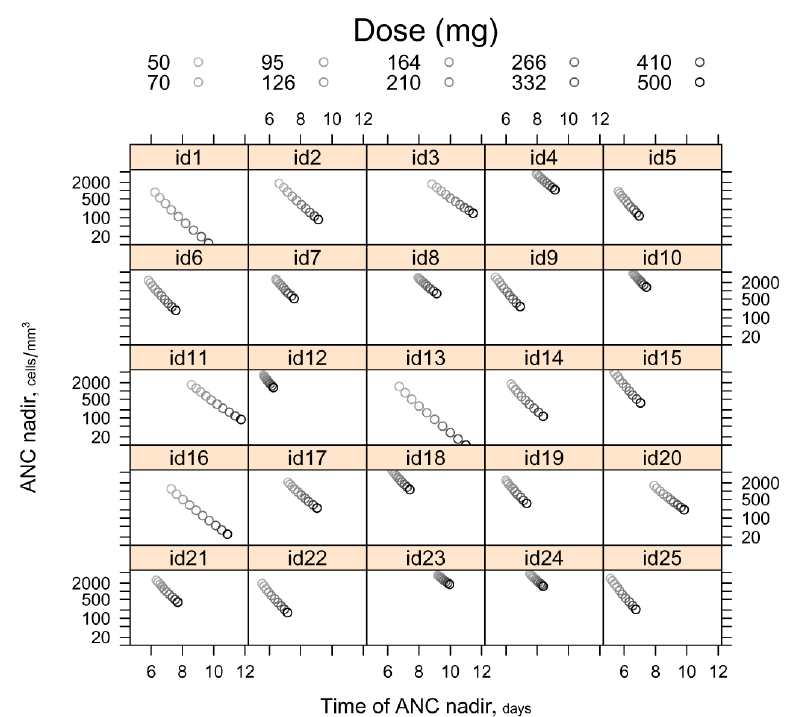
Figure 4. Trajectories of ANC nadirs during dose escalation in 25 randomly-generated individuals. The 10 doses plotted are evenly spaced on a fourth-root scale. Not only are the trajectories themselves nearly linear in (log( ANC ) × time )-space, but each one is traversed at roughly ‘constant velocity’ with respect to 4 dose .